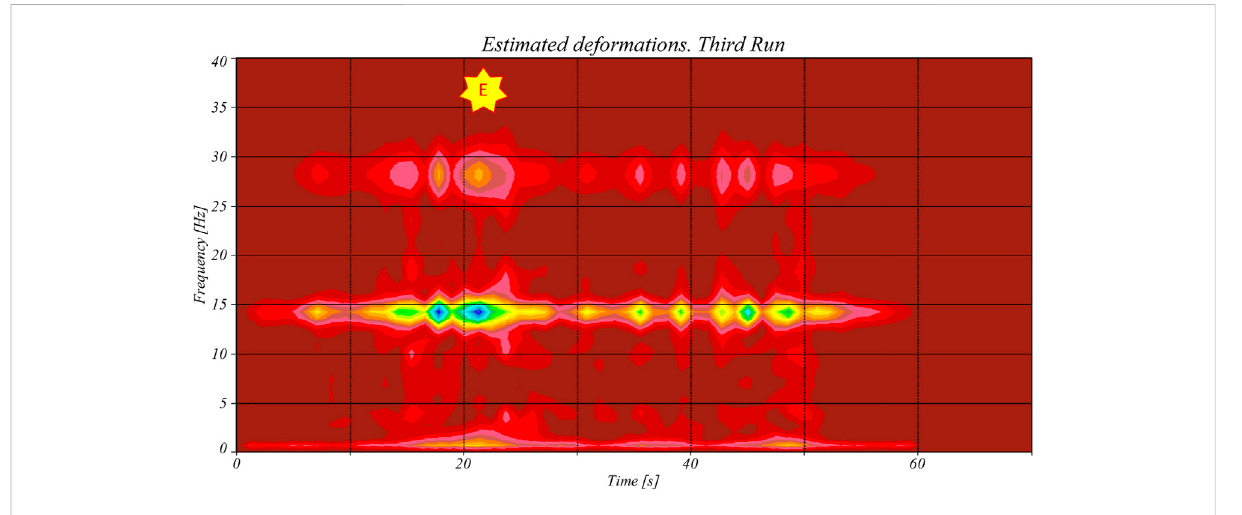
FIGURE 15 Spectrogram of the estimated deformation (Third